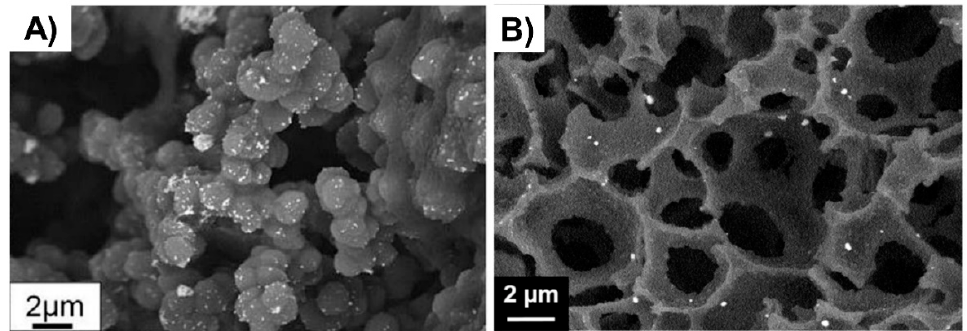
Figure 4. ( A ) Au NPs supported on a biporous, amino-functionalized 2-hydroxyethyl methacrylate- based monolith. [46], Copyright 2017. Reproduced with permission from Elsevier Ltd.; and ( B ) Au NPs supported on a HEMA-based monolith prepared through high internal phase emulsion. [48], Copyright 2018. Reproduced with permission from Elsevier Ltd.